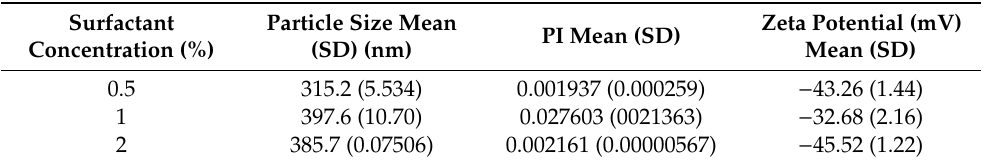
Table 2. Effect of surfactant concentration on particle size and zeta potential; data presented as mean (standard deviation), N = 3.